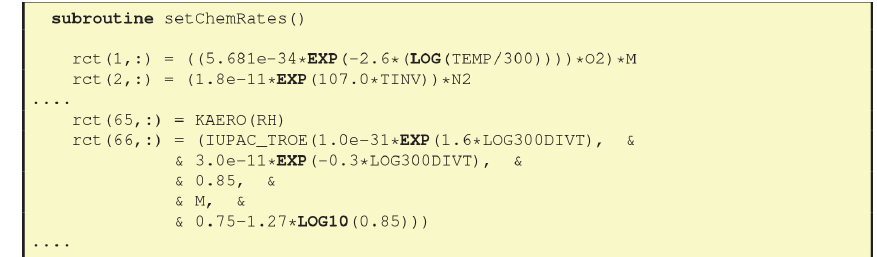
Figure 14. Selected lines from the output file CM_ChemRates_mod.f90 .